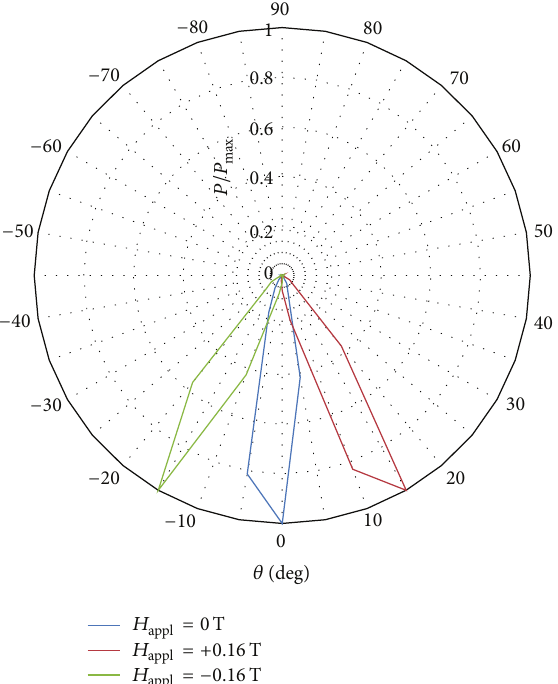
Figure 8: Steering of the antenna radiation characteristic in the transversal plane (𝜑) depending on the applied biasing magnetic